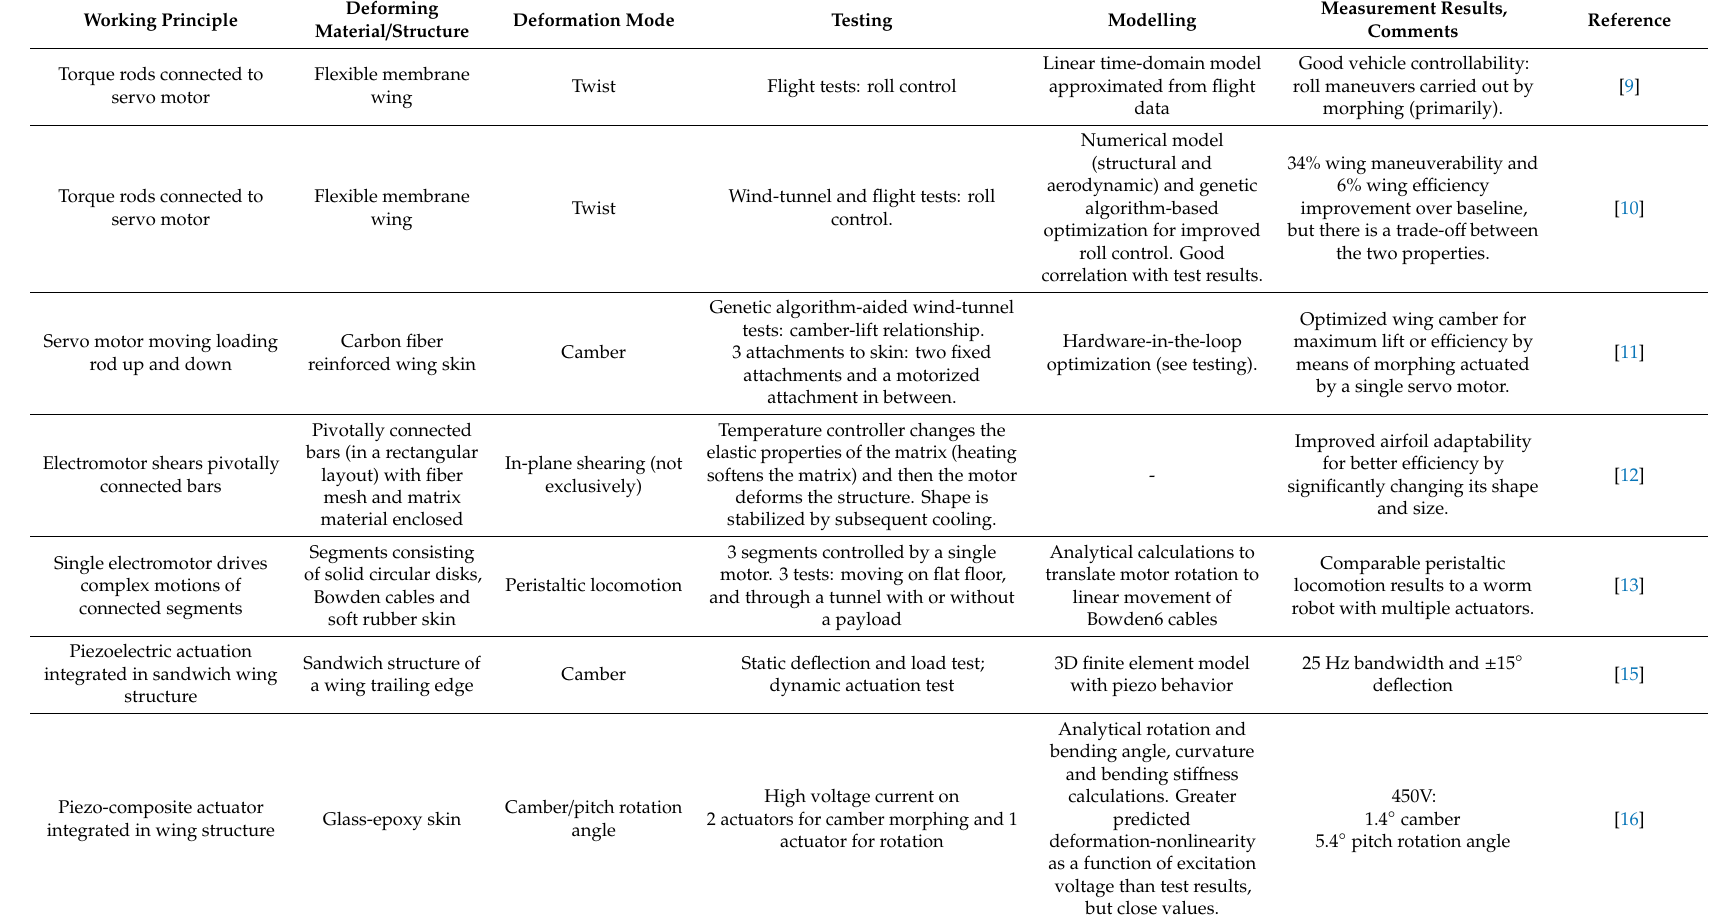
Table 1. Electro-actuated morphing